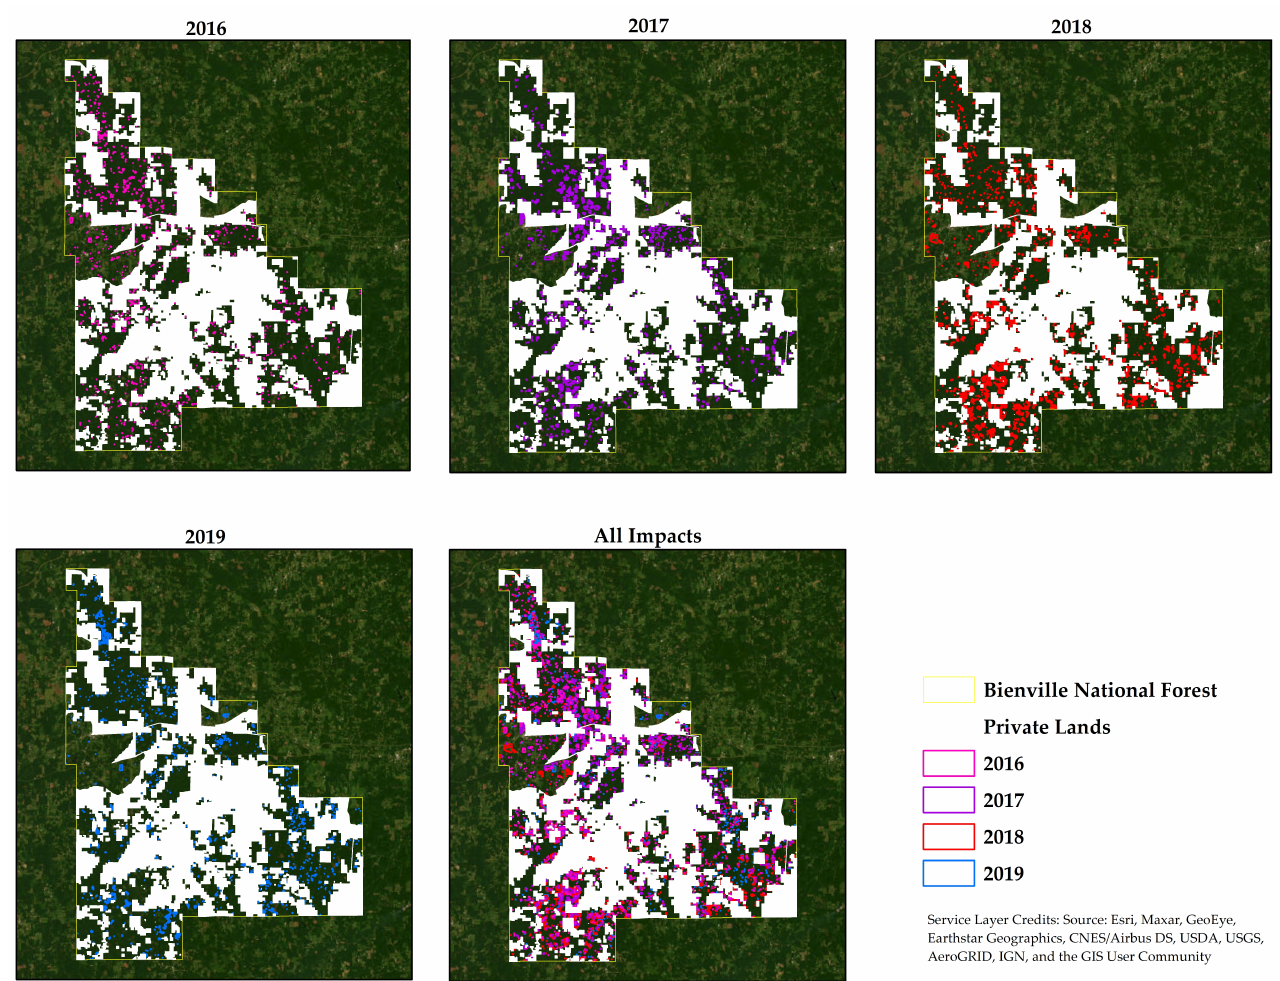
Figure 2. Southern Pine Beetle spots (depicting all areas, active and treated) by year. The difference observed between Years ( p = 0.0519) could be best described as mod- erate, where 2018 was greater than the others (Figure 3). Highly significant differences were concluded to be present between statuses ( p = 0.0002). Actively infested spots and those occupied by standing dead trees were significantly more common than sites where cut-and-remove or hazard mitigation had occurred (Figure 4). Diagnostically, the negative binomial regression model provided good fit. Deviance was 23.33 with 12 degrees of freedom, and overdispersion was minimal ( ϕ = 1.94). The Akaike Information Criterion was 249.70, nearly five times below that produced by the Poisson regression model, where lower is better